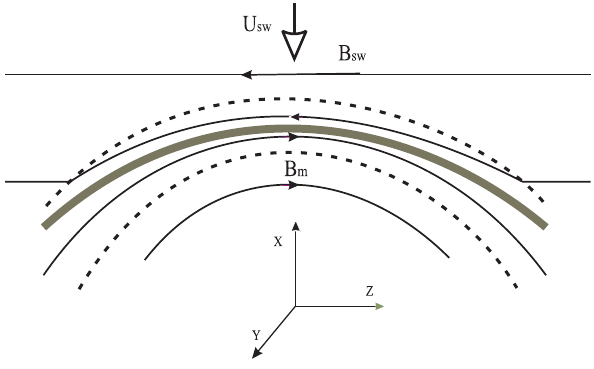
Fig. 1. General view of a curved current layer separating antiparal- lel magnetic fields.